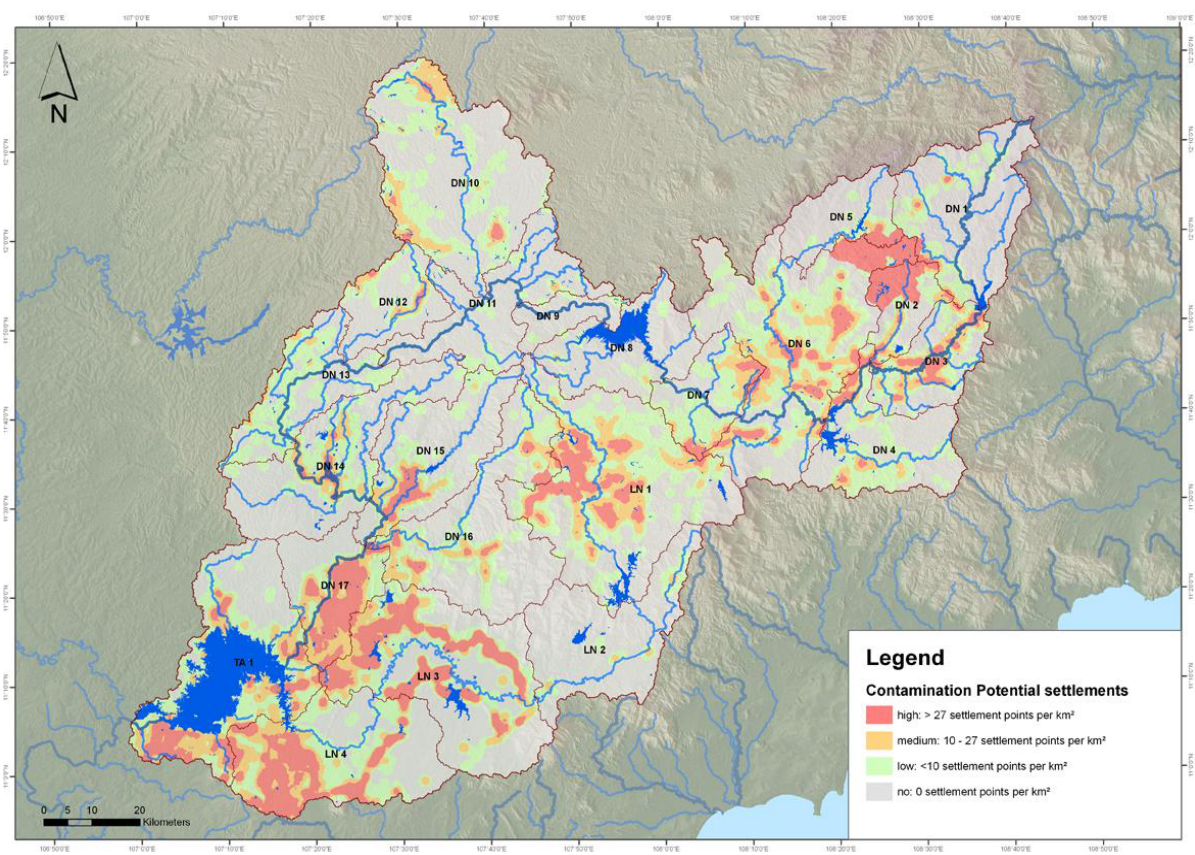
Figure 11. Map of contamination potential of settlements (path 1).